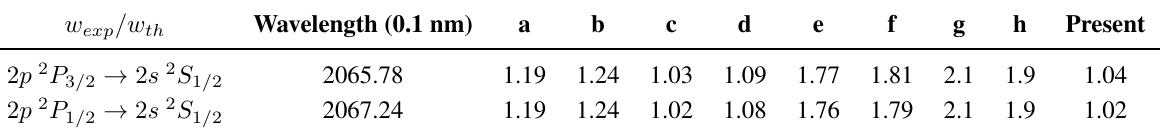
Table 2. Ratio of experimental electron-impact half-widths w [18] of 2p-2s line in B III exp = 10 : 6 eV and an to different theoretical half-widths w for an electron temperature of T th e = 1 : 81 (cid:2) 10 18 cm (cid:0) 3 . The letters from a to h denote electron density of N e